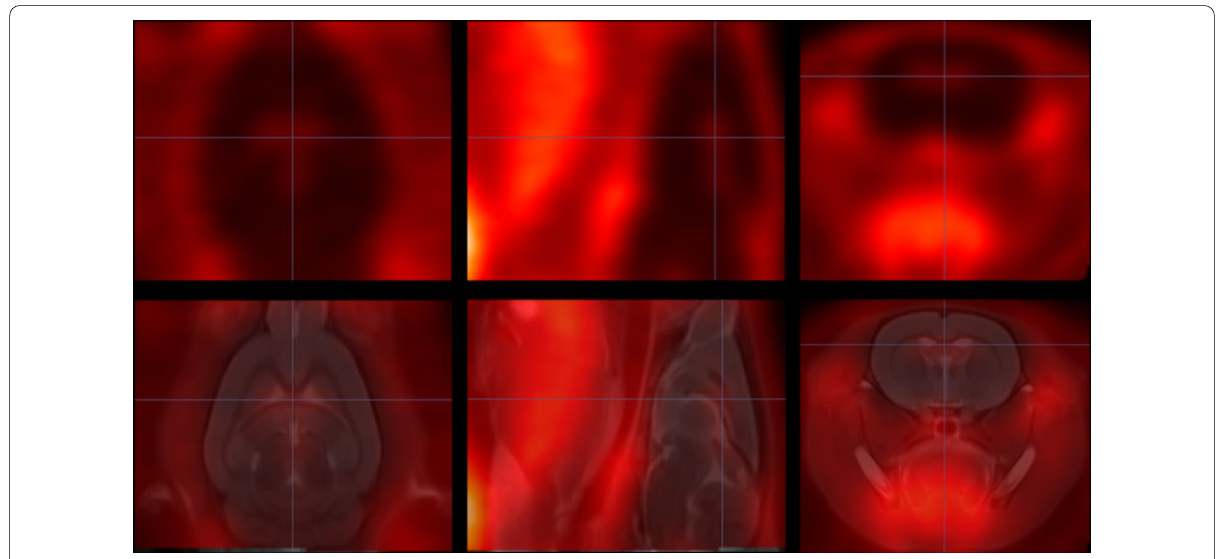
Fig. 2 The rat GE180 template. The upper row of images is the coronal plane, sagittal plane and cross section of the template. The lower row of images is the overlaid images of the template on an MRI T2 template. The cross curve was focused on the area around the